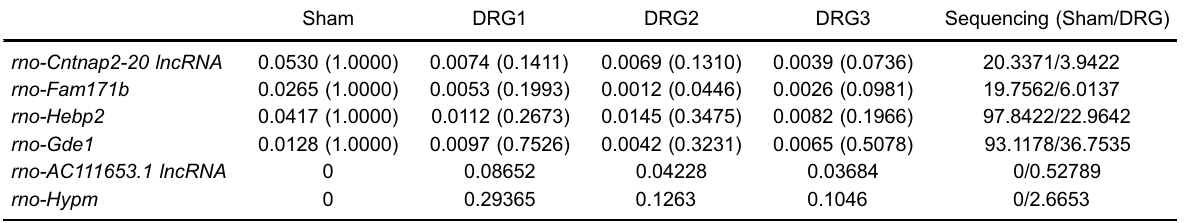
Table 8. Real time qPCR quanti fi cation of interest/GAPDH (interest DRG/Sham) gene expression levels.